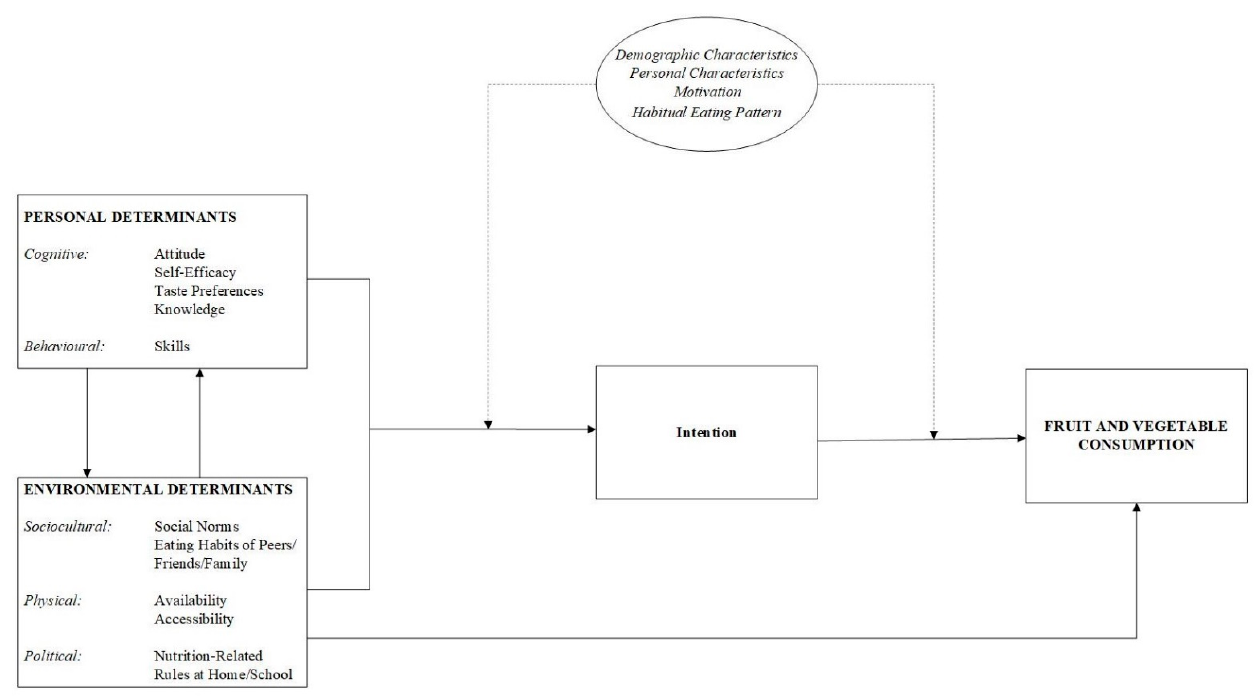
Figure 1. Conceptual framework of the determinants of children’s FV consumption (adapted from [8,23]).